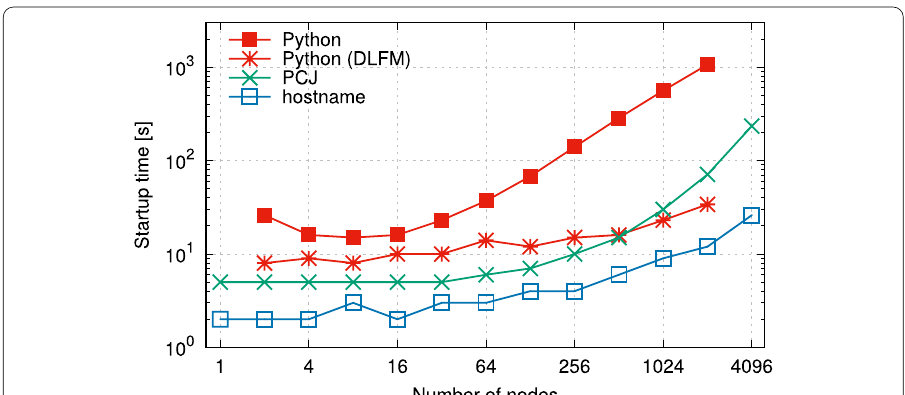
Fig. 1 PCJ startup time (from [10]) compared to the Python loading time for original and modified Python installation (see [12]). The execution time of the hostname command run concurrently on the nodes is plotted for